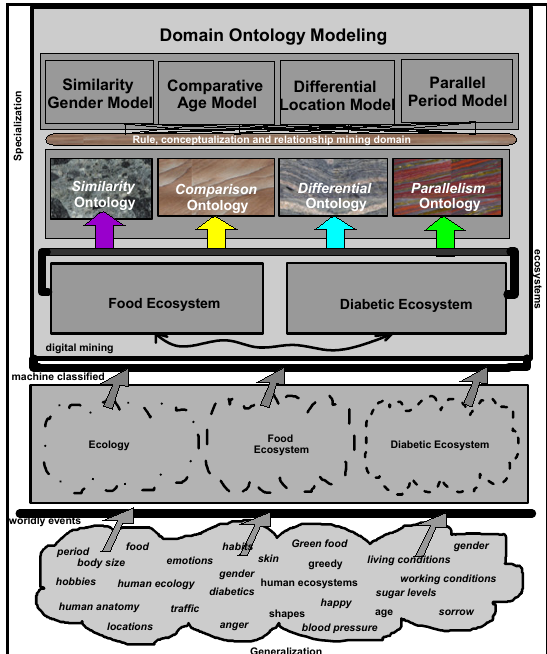
Figure 1. Connecting multiple domain